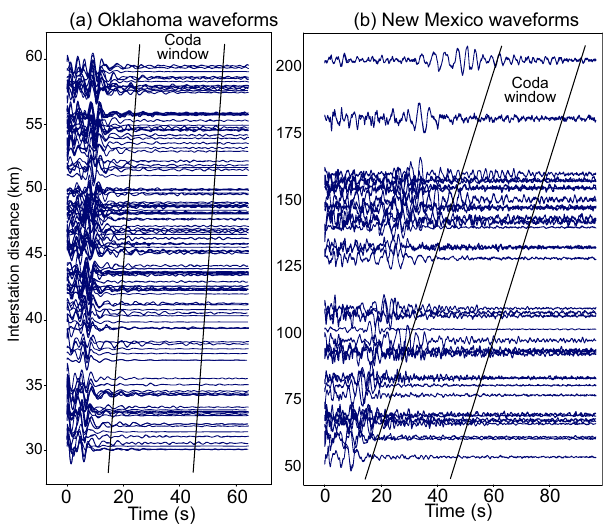
Fig. 3 Empirical Green ’ s functions. Empirical Green ’ s functions (Z-Z correlations), for a Oklahoma, and b New Mexico, ordered by interstation distance. The black lines bracket the coda used for the velocity